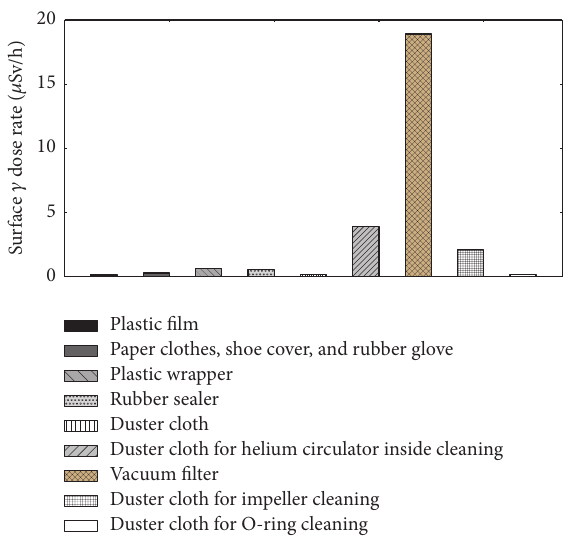
Figure 13: The daily on-site collective dose that occurred in the reactor maintenance hall during the primary work process (the number of on-site workers was about 10 ∼ 20 every